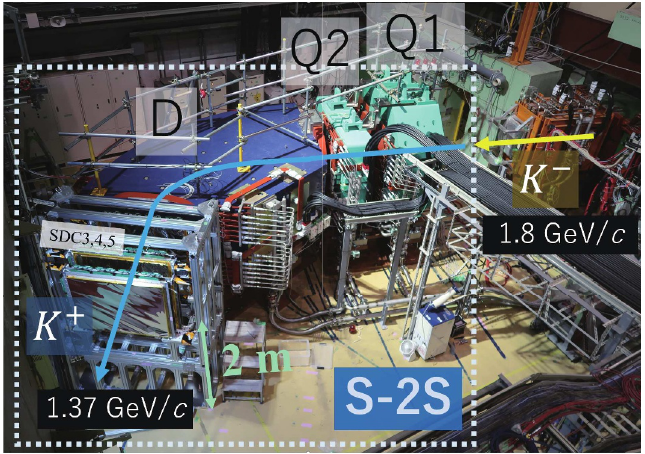
Figure 1. A photograph of S-2S which is installed in the K1.8 beam-line at Hadron Experimental Facility of J-PARC as of the end of June, 2022. SDC3–5 are drift chambers for the particle tracking, and the back face of SDC5 is seen in the photograph. Plastic scintillation counters, aerogel-Cherenkov counters, and water-Cherenkov counters are installed in the downstream of SDC5 in this order.